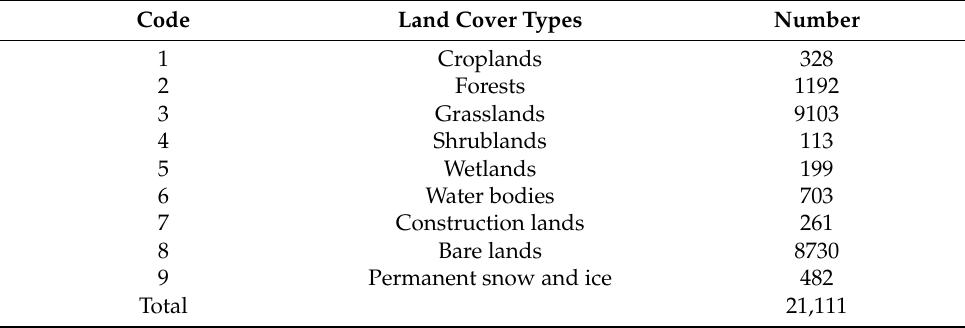
Table A1. The number of sample